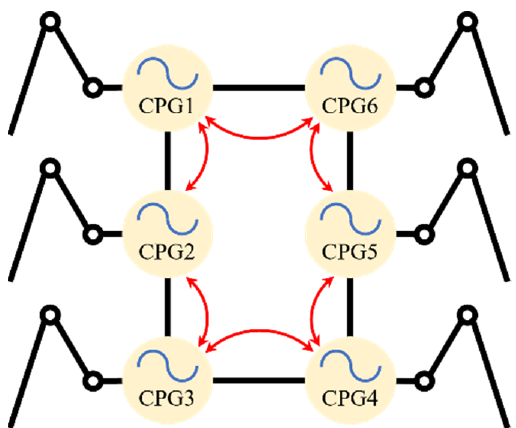
Figure 2. Circularly bidirectionally coupled CPG network.